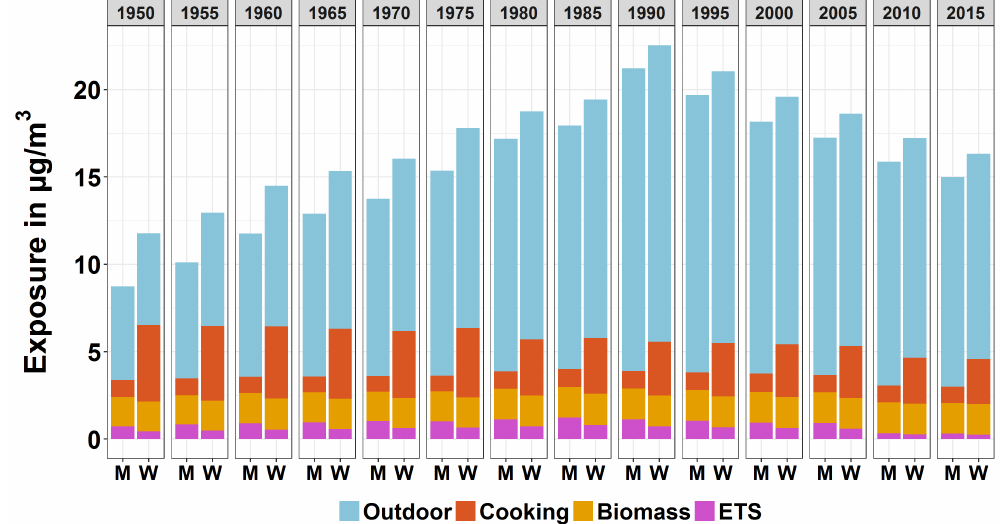
Figure 5. Population-weighted arithmetic mean NO 2 exposure by source and gender for European countries from 1950 to 2015. The “M” stands for “Men” and “W” stands for